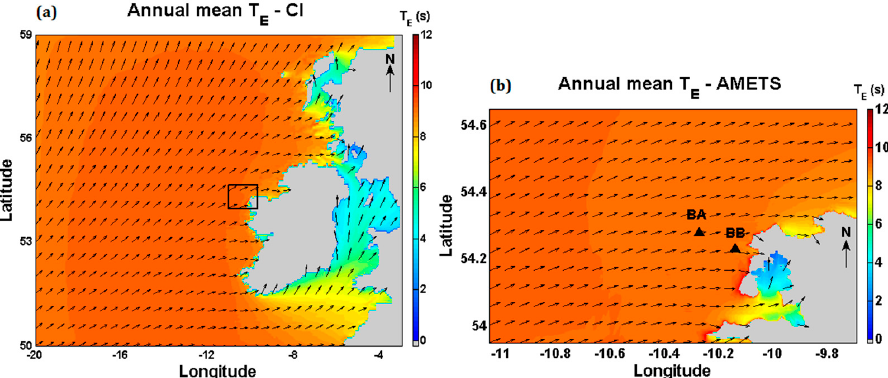
Figure 11. 12-year annual means of T E (s) and MWD for ( a ) CI model and ( b ) AMETS model.